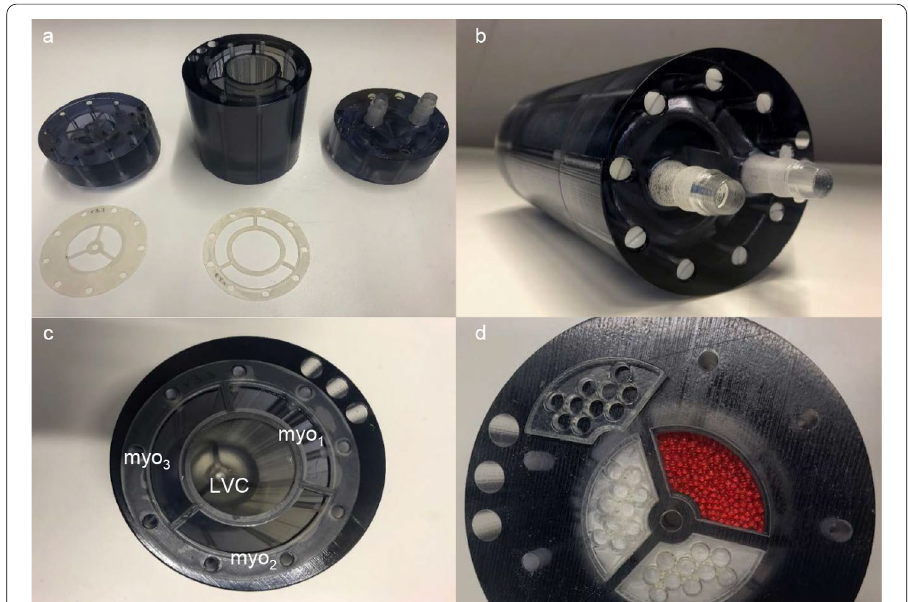
Fig. 2 Overview of the realized myocardial perfusion phantom. a The individual 3D printed parts and silicone seals. In b , all pieces were assembled and secured by nylon screws (2 9). c The left ventricular cavity (LVC) × and the three myocardial segments (myo 1–3 ) are indicated in cross section. d Demonstrates fabrication of the myocardial inlays. The tissue mimicking material was enclosed by a glass wool layer and a 3D printed